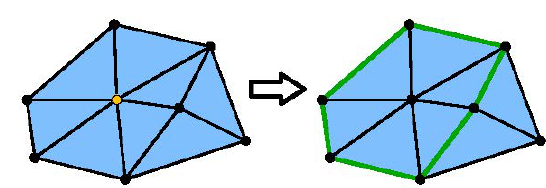
Figure 38: A simplex ( yellow ) and its link ( green